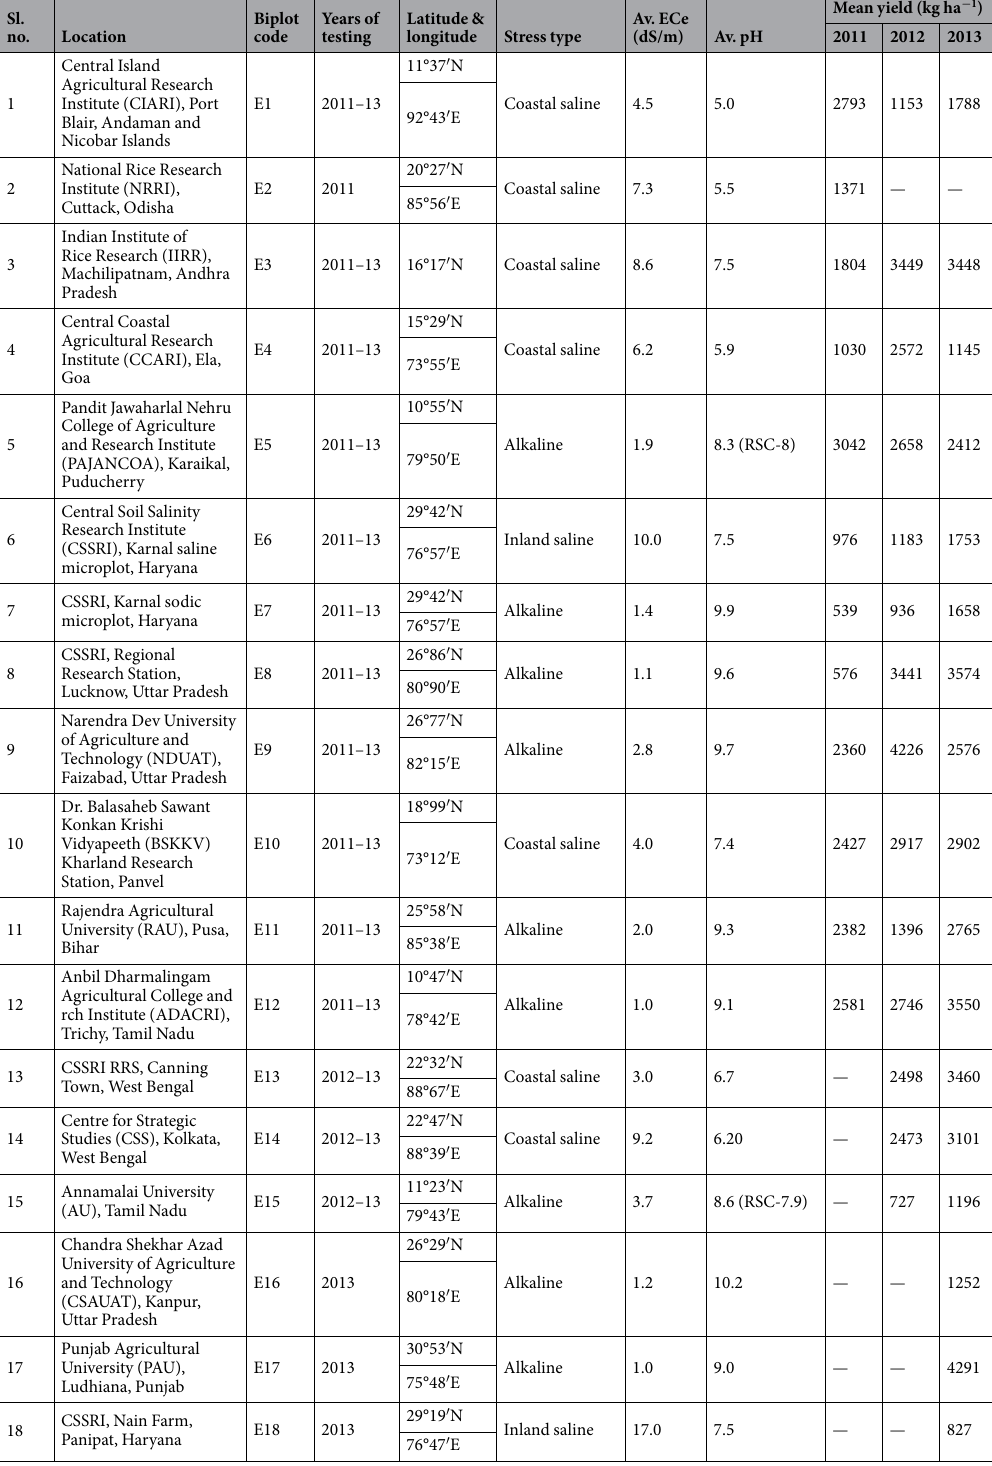
Table 5. Description and characterization of the locations used for the evaluation of rice genotypes during 2011–13 (3